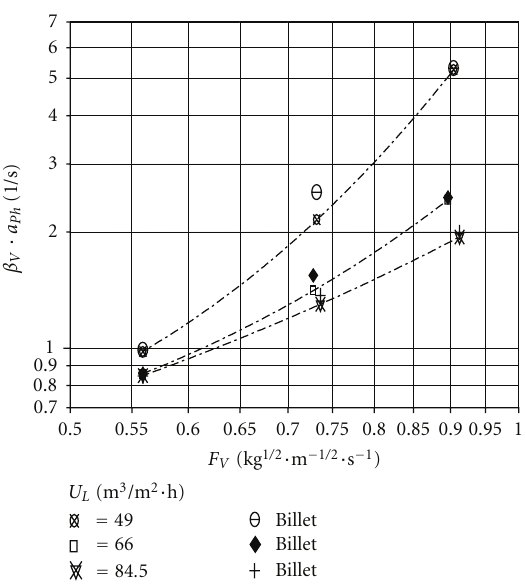
Figure 4: Global mass transfer coe ffi cient versus the gas capacity